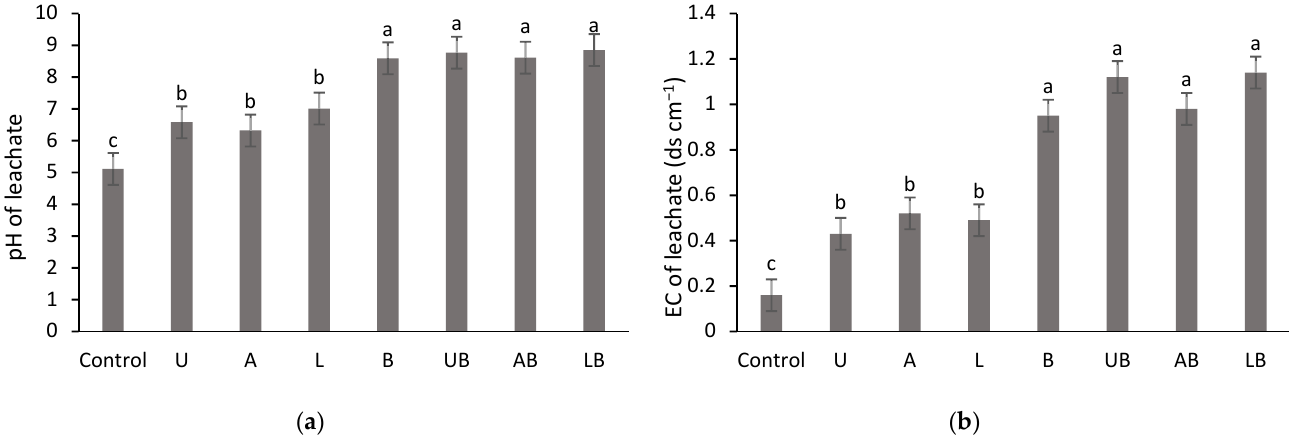
Figure 3. Influence of treatments on pH ( a ) and electrical conductivity (EC) ( b ) of leachates from the soil at the end of the experiment. Significant differences of means are shown by different lowercase letters.